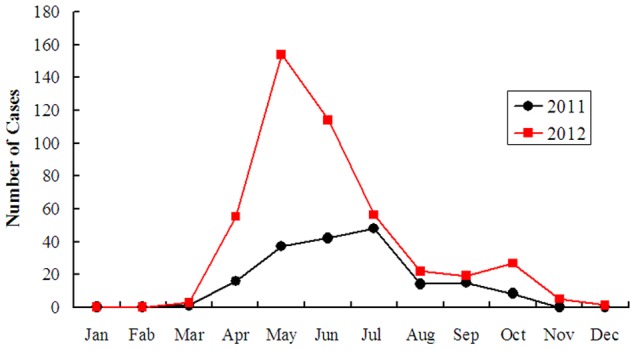
Monthly distribution of reported FTLS cases: Henan Province, China, January 2011 to December 2012.